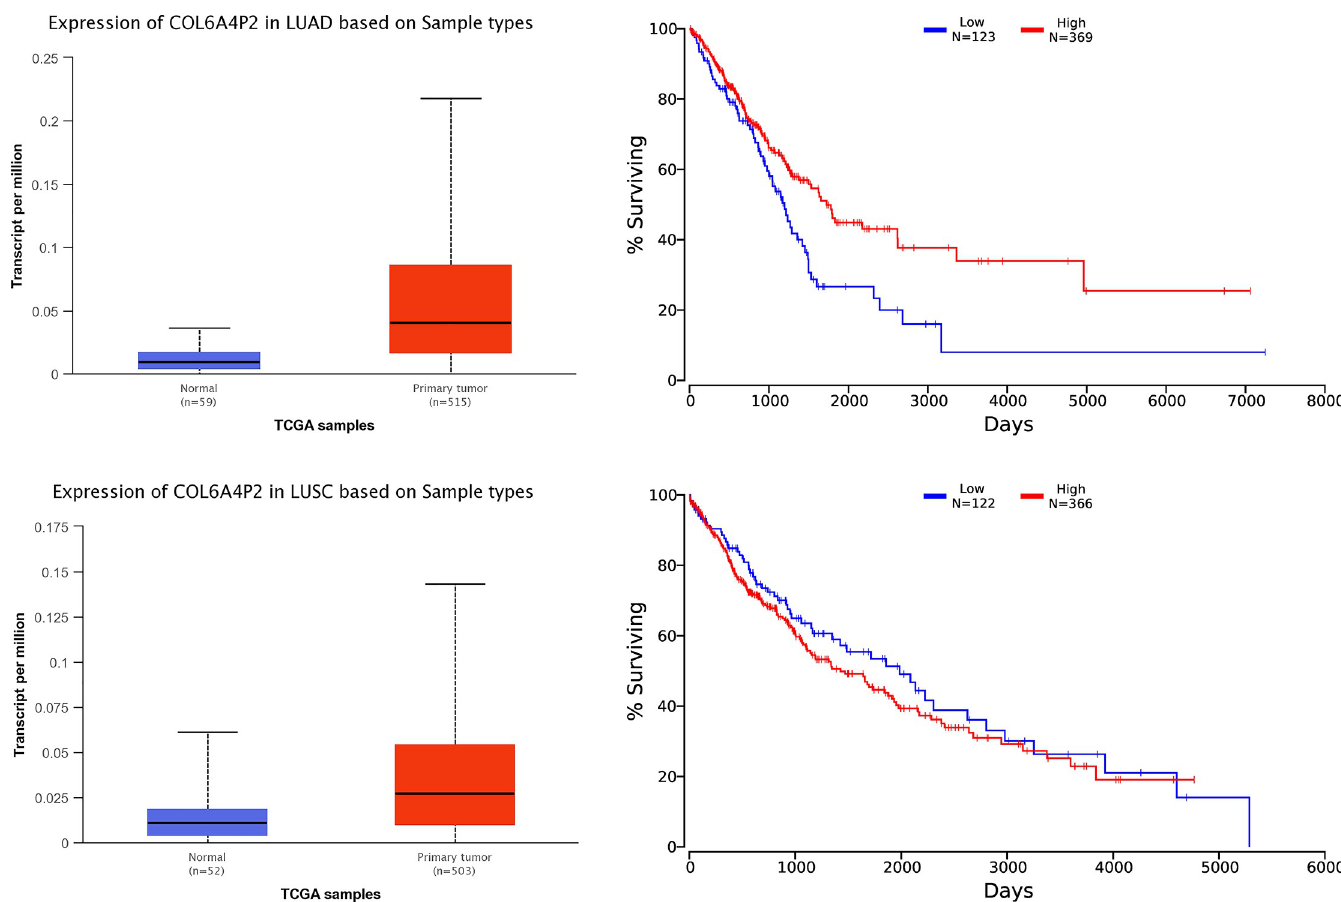
Fig 2. Prediction of the expression and prognosis of COL6A4P2 gene in LUAD and LUSC. (A) Expression of COL6A4P2 in LUAD and normal tissues ( p = 1.62 × 10 − 12 ). (B) Effect of COL6A4P2 gene expression on survival rate ( p = 4.25 × 10 − 3 ). (C) Expression of COL6A4P2 in LUSC and normal tissues ( p = 2.44 × 10 − 7 ). (D) Effect of COL6A4P2 gene expression on survival rate ( p = 3.00 × 10 − 1 ).